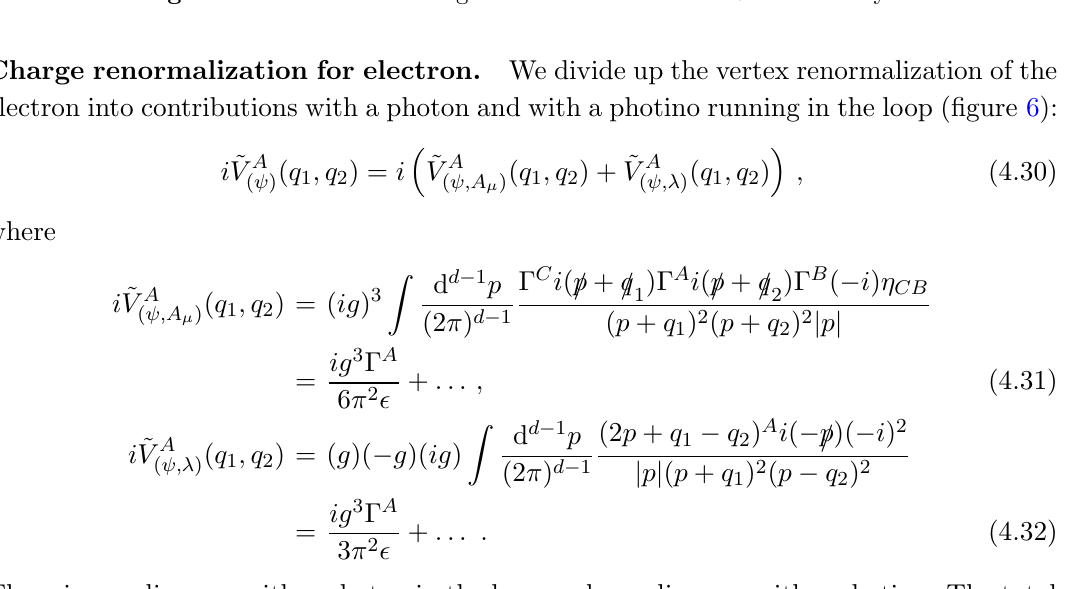
Figure 6 . The electron charge renormalization in the N = 1